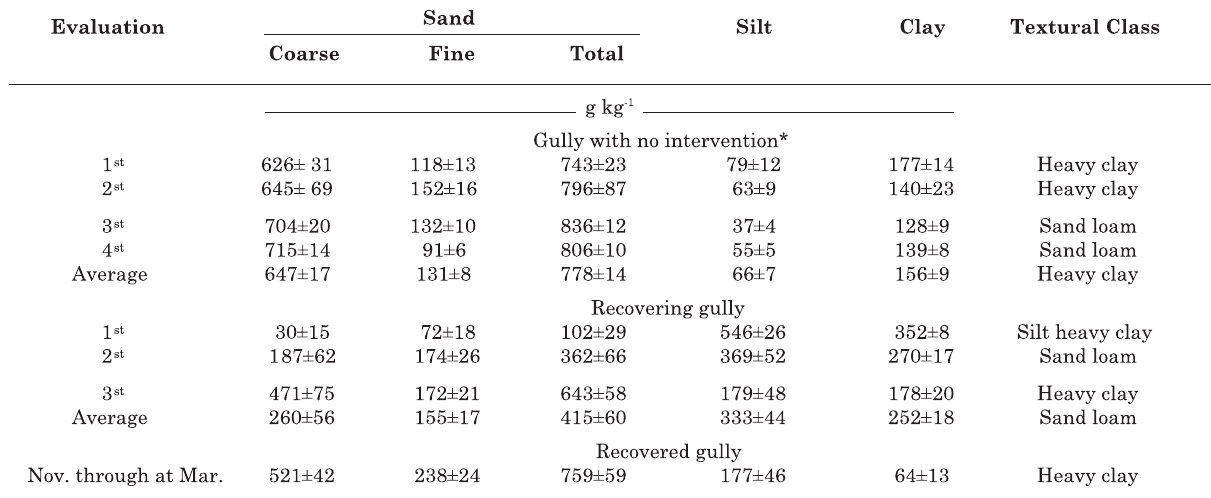
Table 4. Granulometry of sediments collected in evaluations of the studied gullies ± standard